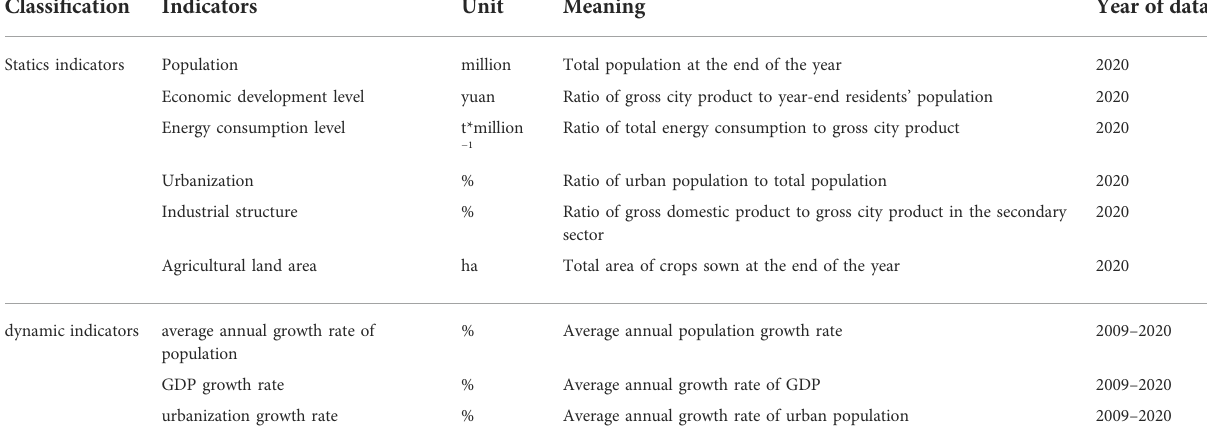
TABLE 1 Cluster analysis index